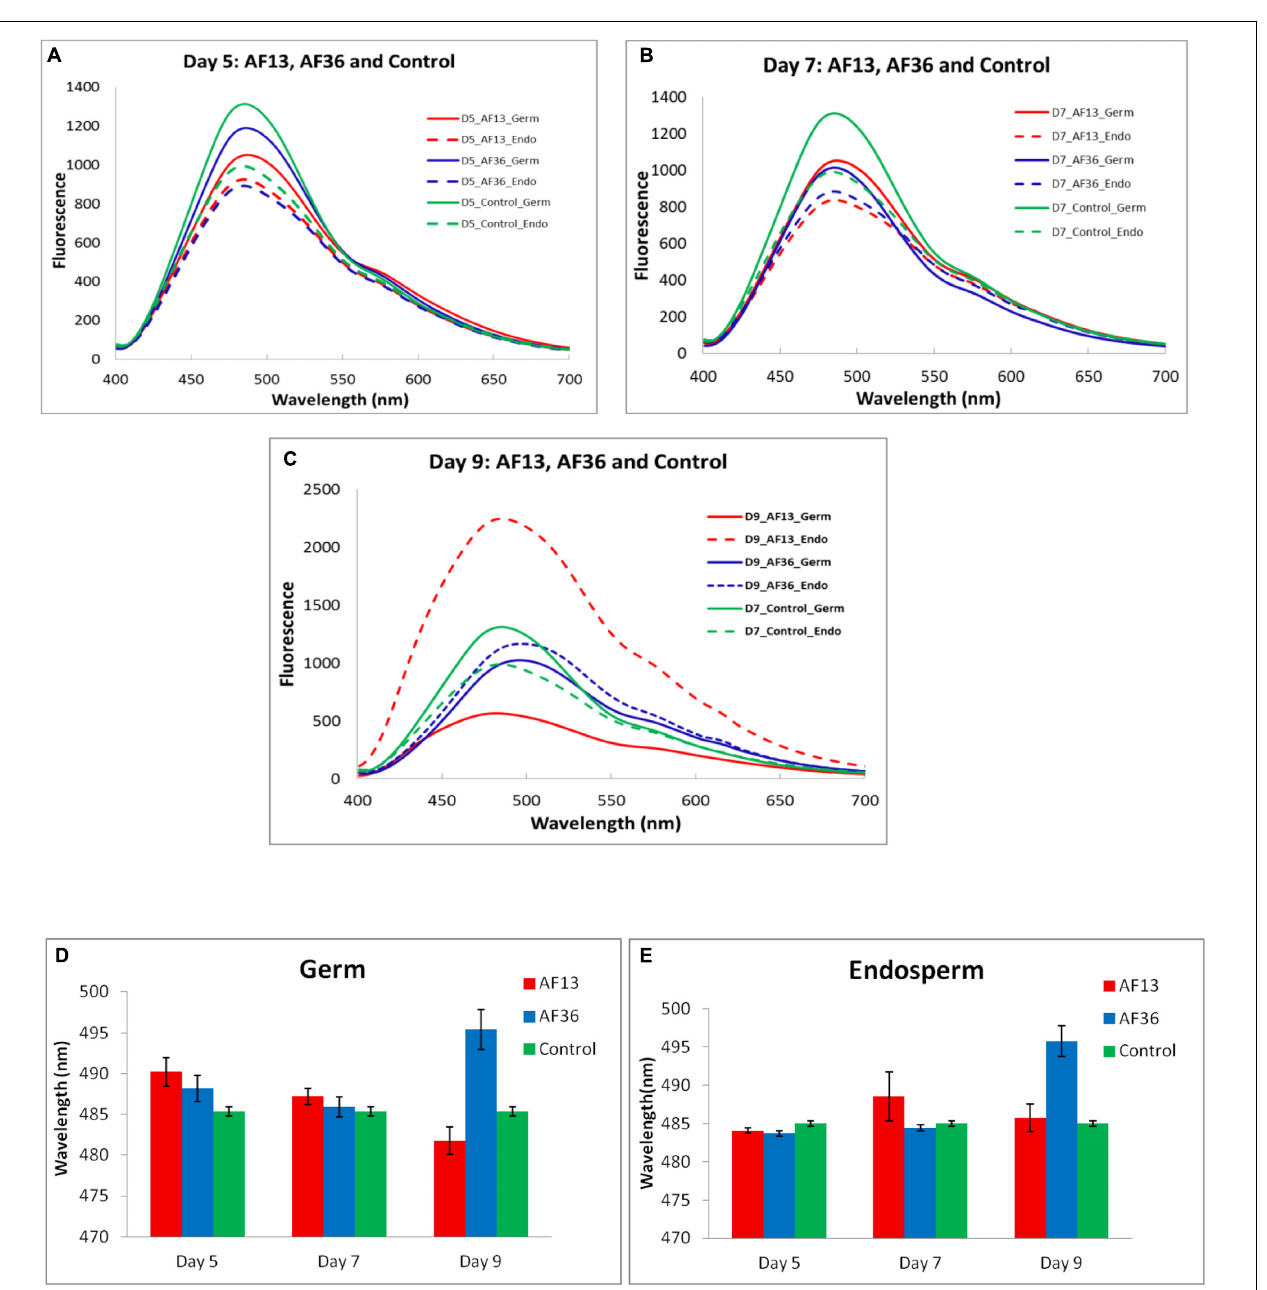
FIGURE 5 | Fluorescence spectral means (A–C) and analysis of variance between fluorescence peak means ± SE of maize kernel components ( D -germ and E -endosperm), inoculated with toxigenic and atoxigenic strains of A. flavus (AF13 and AF36) at three time points over a 9 day period ( A -Day 5, B -Day 7, and C -Day 9), including